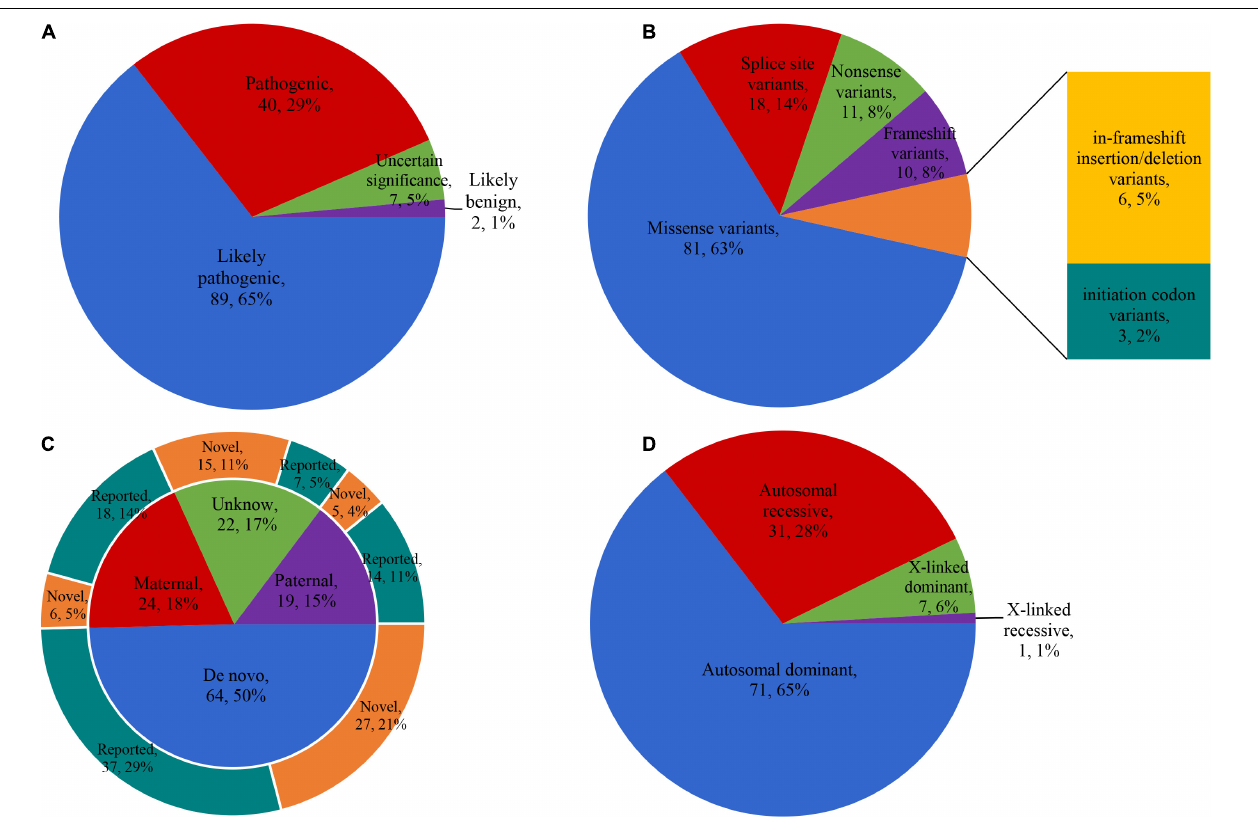
FIGURE 2 | Characteristics of the variants detected. (A) The classification of 138 variants according to ACMG/AMP guidelines. (B) Mutation types of 129 pathogenic/likely pathogenic variants. (C) Genetic origin of 129 pathogenic/likely pathogenic variants and the proportion of reported and novel. (D) The disease inheritance pattern of 110 probands with clear molecular diagnosis. ACMG/AMP, American College of Medical Genetics and Genomics and the Association for Molecular Pathology.